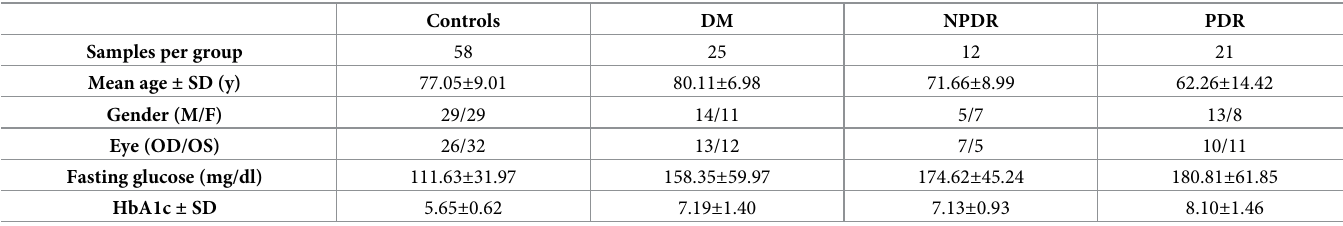
Table 2. Clinical patient data for all groups. Abbreviations: y = year; SD = standard deviation; M = male; F = female; OD = right eye; OS = left eye.